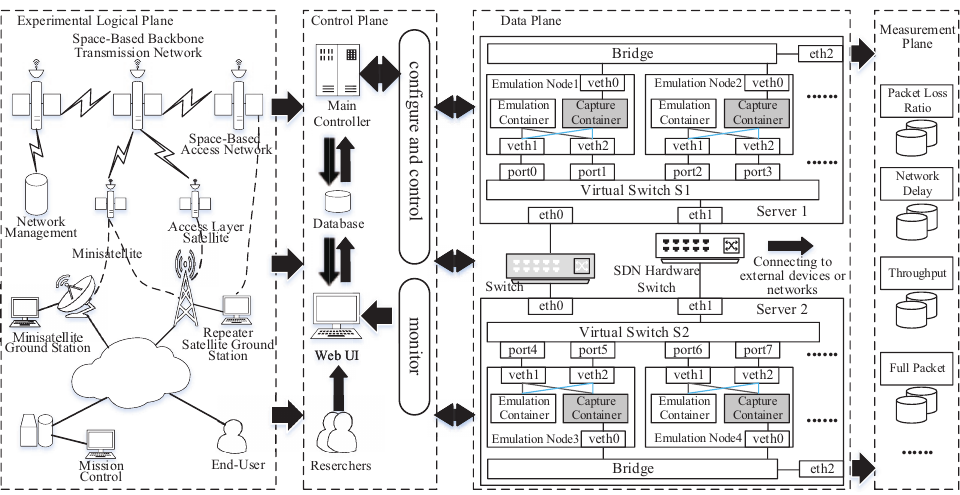
Figure 1. Architecture of the proposed